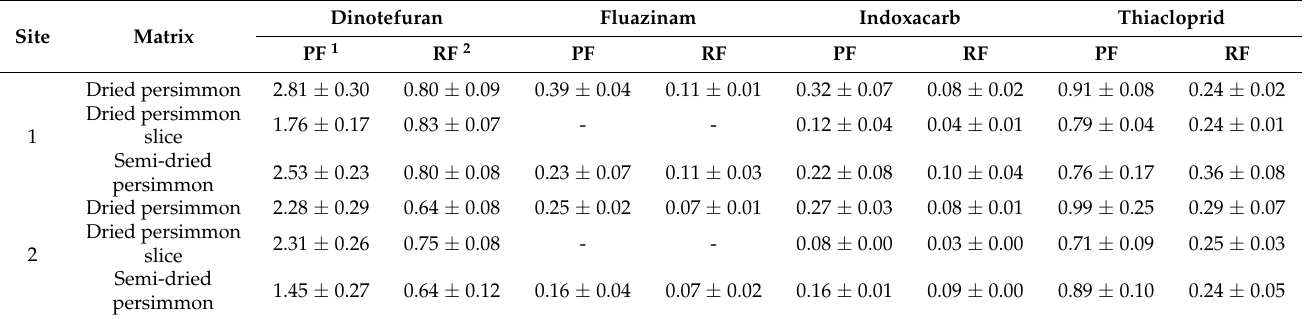
Table 6. Processing factor and reduction factor of test pesticides caused by